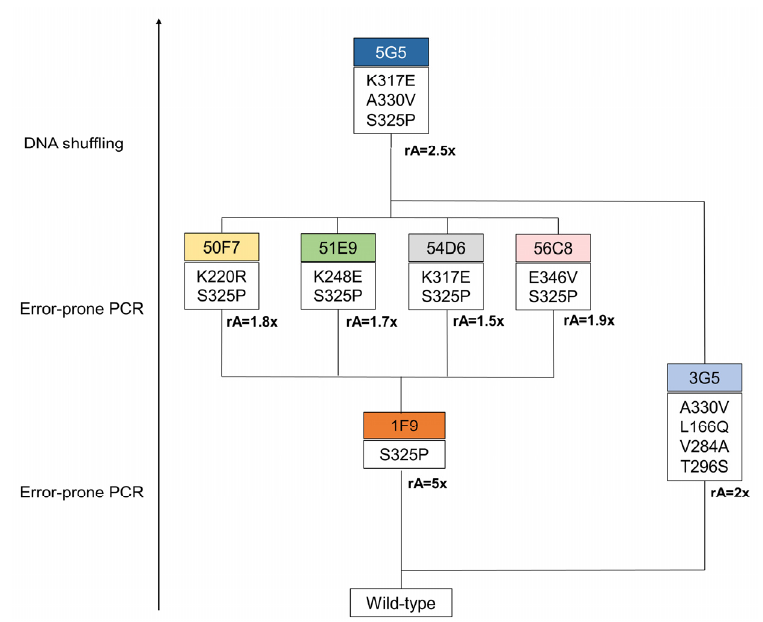
Figure 1. Lineage of Bs DyP variants generated in this study. In the first generation, a total of 614 variants, generated through error-prone PCR, were screened in 96-well plates using 1 mM of DMP. The 1F9 variant was selected on the basis of its 5-fold increased activity in crude extracts compared with the parent. Next, the second generation was evolved from the 1F9 variant as the parent. In this round, 365 variants, resulting from error-prone PCR, were screened in 96-well plates. The variants 50F7, 51E9, 54D6 and 56C8 were identified as having a slightly higher activity (between 1.5 and 1.9-fold) when compared to the parent. In the third generation, variants were constructed using DNA shuffling, where genes from variants of the second generation were recombined with the 3G5 gene, from the first round of evolution, with a 2-fold increased activity in crude extracts when compared with the wild type. In this round of evolution, 588 variants were screened in 96-well plates. From this process resulted one hit variant, 5G5, with 2-fold increased activity at pH 4. rA represents the relative activity to the parent. Table 1. Spectroscopic and redox properties of purified Bs DyP wild type and variants.